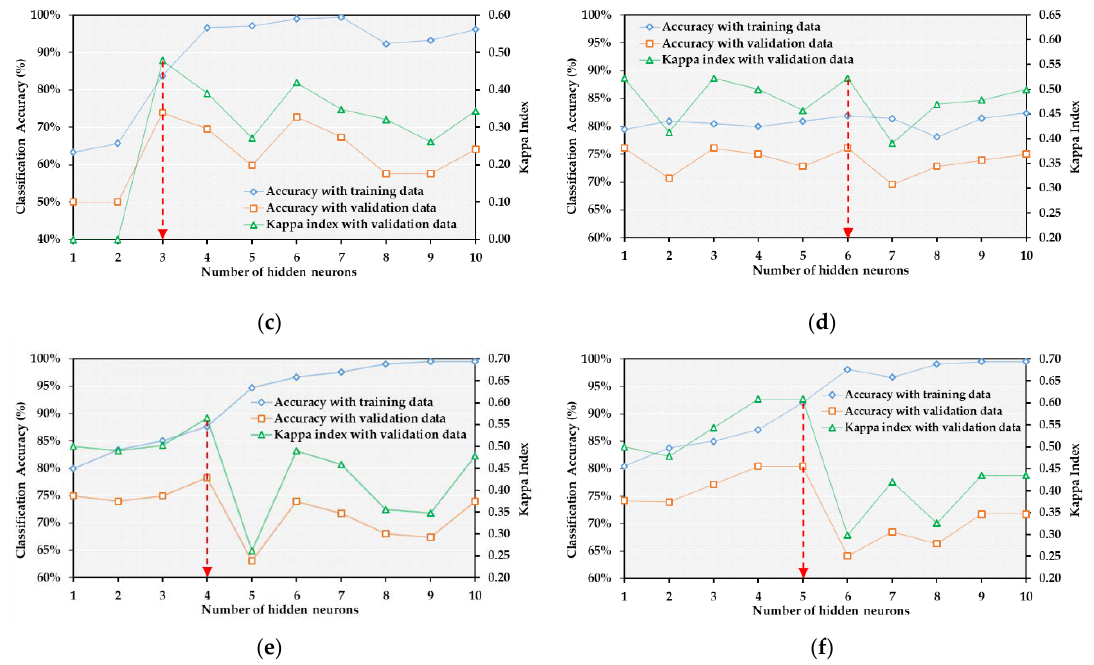
Figure 7. Performance of MLP models according to the activation function and the number of neurons: ( a ) Hard-lims, ( b ) Sat-lins, ( c ) Rad-bas, ( d ) ReLU, ( e ) Log-sig, and ( f ) Tan-sig functions.